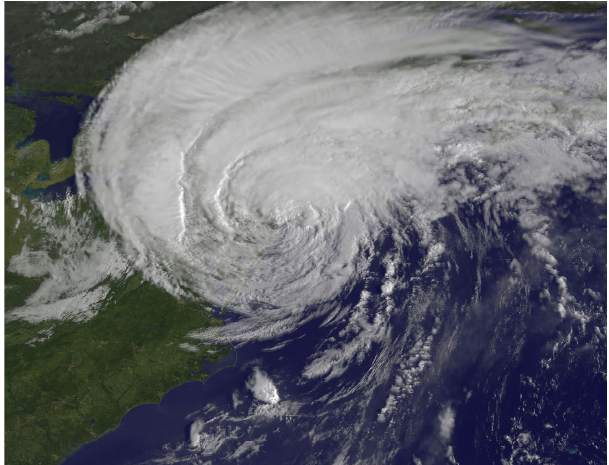
Figure 1. Geostationary Operational Environmental Satellite (GOES) east image of Hurricane Irene making landfall on 28 Au- gust 2011 (image source: National Oceanic and Atmospheric Ad- ministration (NOAA), 2011).